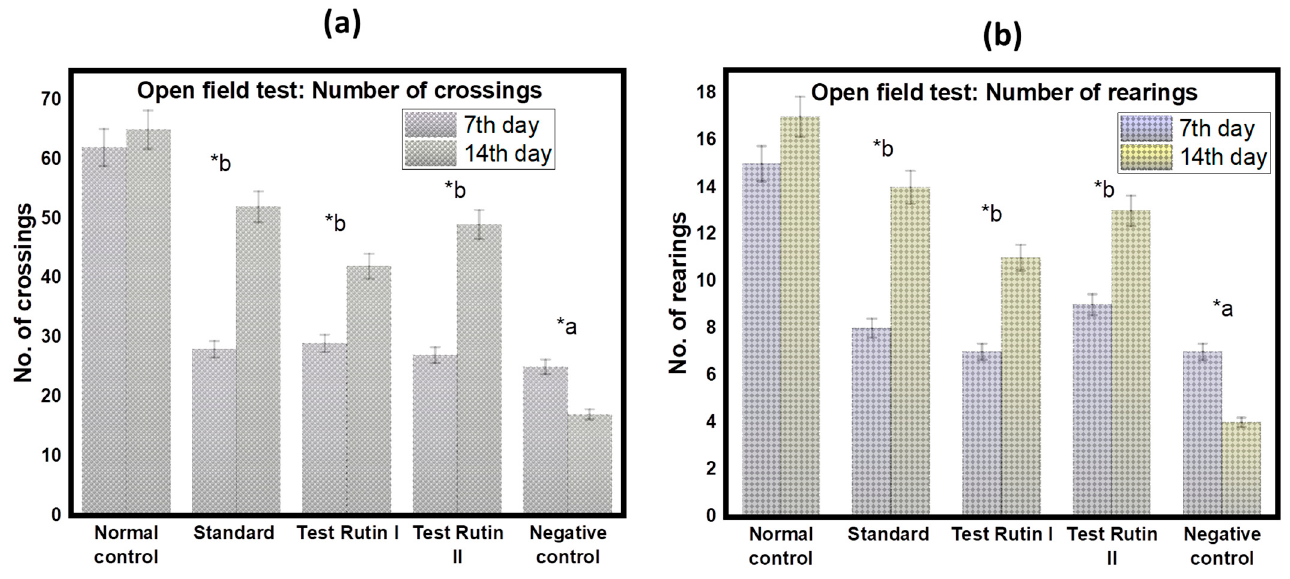
Figure 4. Antianxiety activity in rats after treatment using open field test; ( a ) Number of crossings; ( b ) Number of rearings. The results are expressed as mean ± SD values ( n = 6). The significance of the difference was determined by two-way ANOVA; * p < 0.05 vs. respective controls. a = normal control vs. reserpine control; b = reserpine control vs. test.